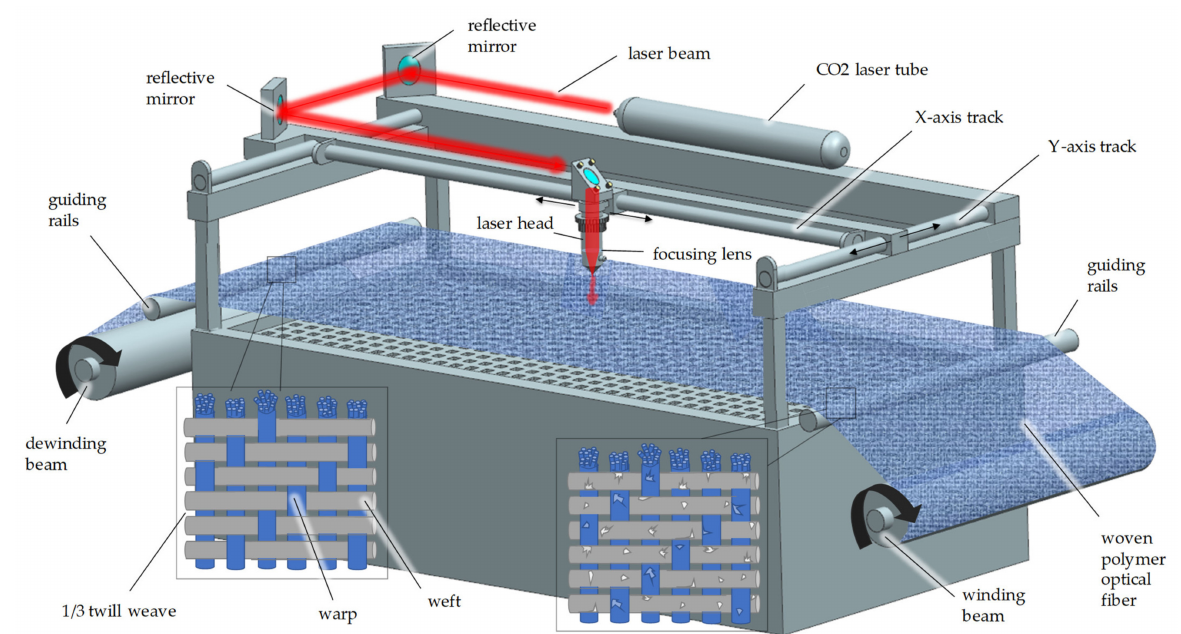
Figure 9. Continuous thermal surface modification of a POF fabric by laser